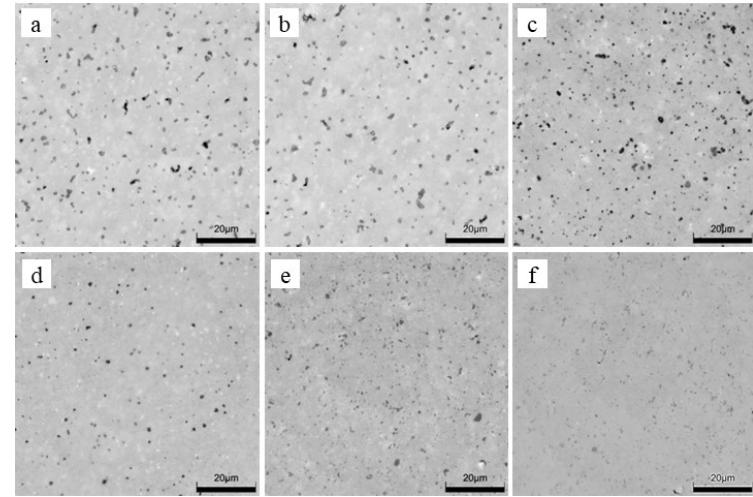
Figure 1. Optical images of non-etched microstructure in the studied materials containing ( a ) 3%,